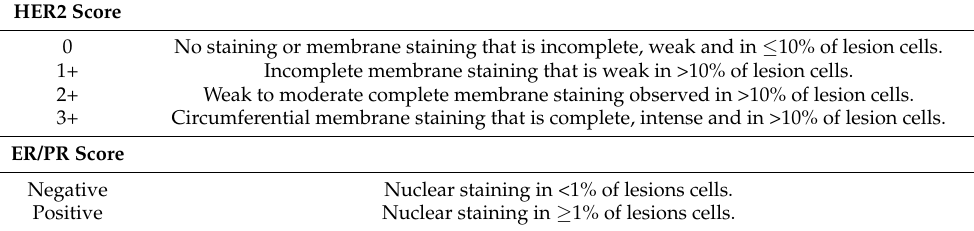
Table 2. Allred score guidelines for ER and PR evaluation. Score for the percentage of positive lesion cells